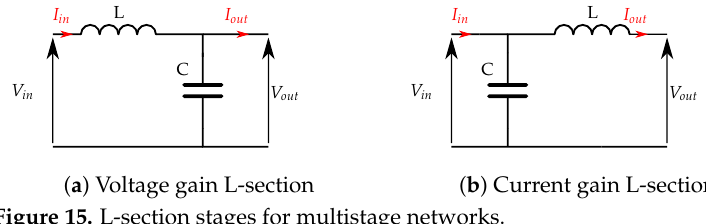
Figure 15. L-section stages for multistage